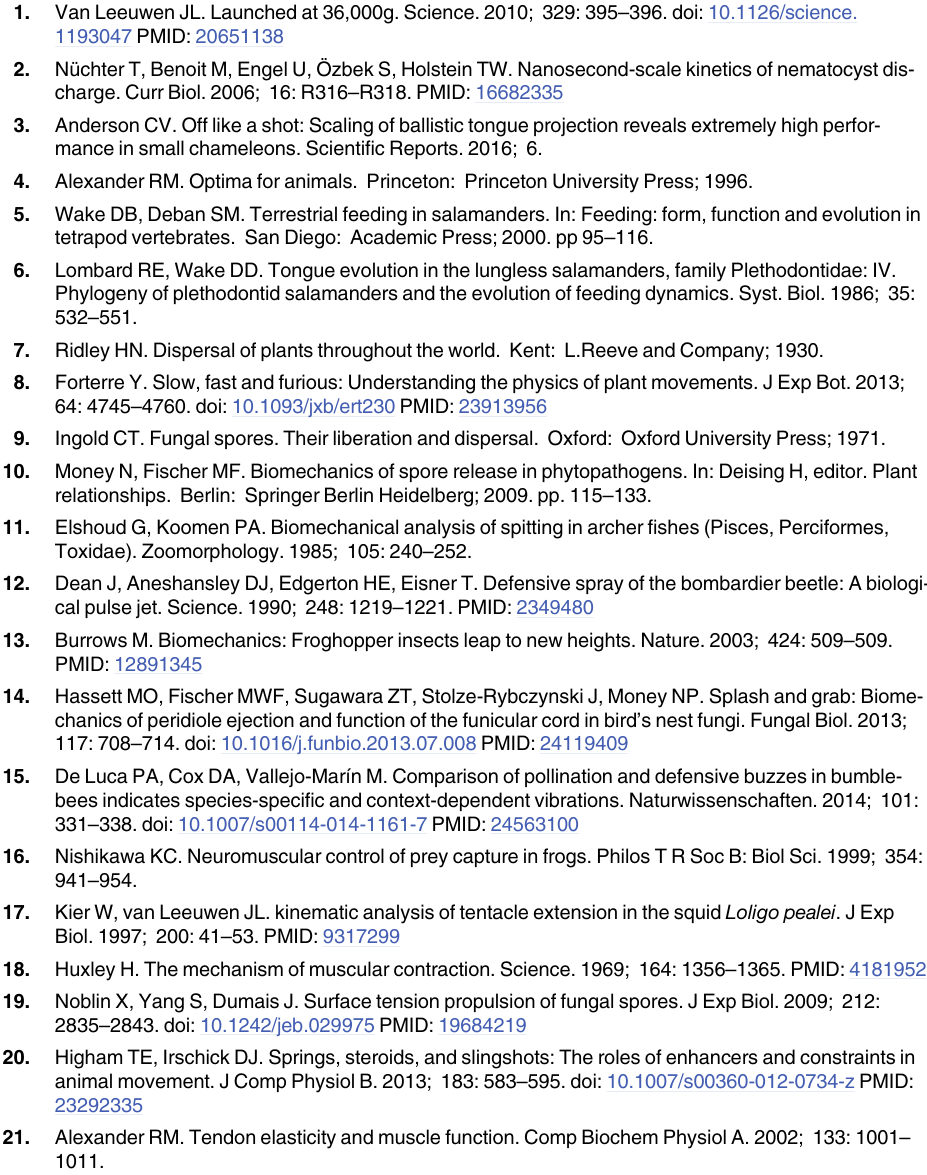
S2 Fig. Flow chart for the identification and selection of literature about shooting mecha- nisms in plants and